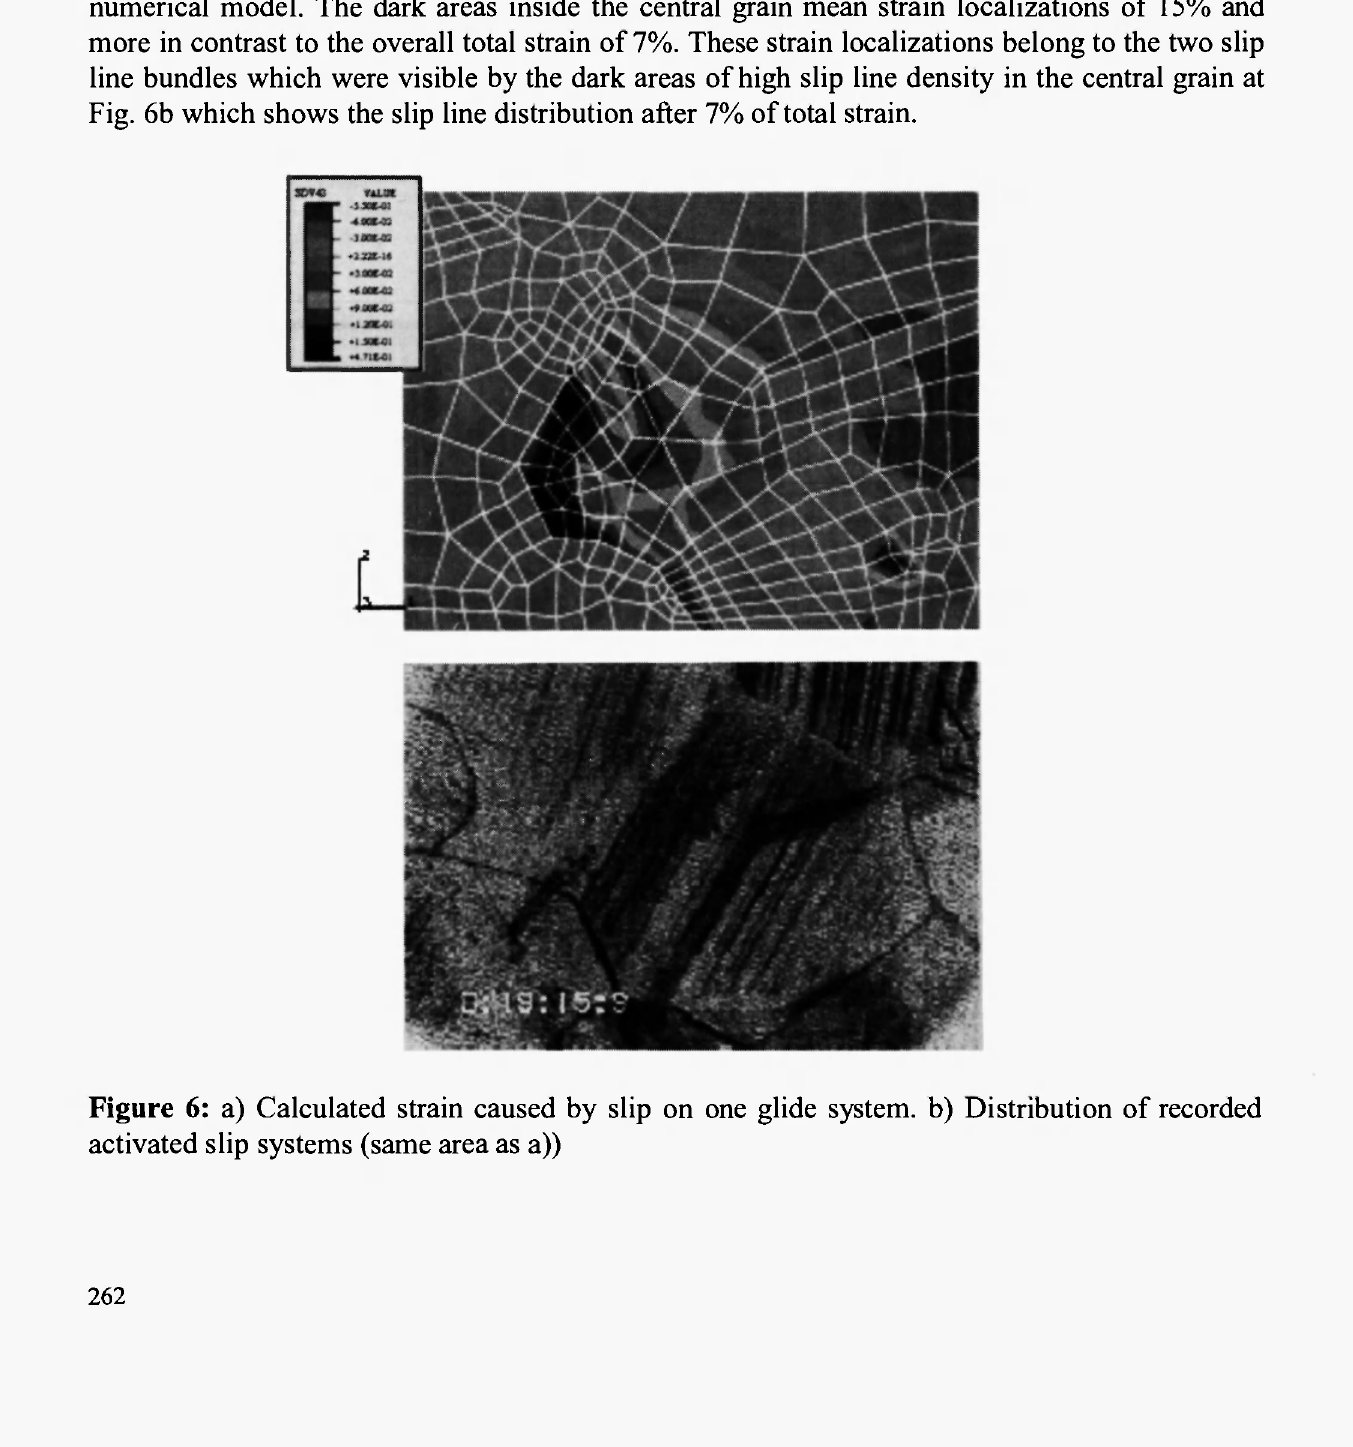
Figure 6: a) Calculated strain caused by slip on one glide system, b) Distribution of recorded activated slip systems (same area as